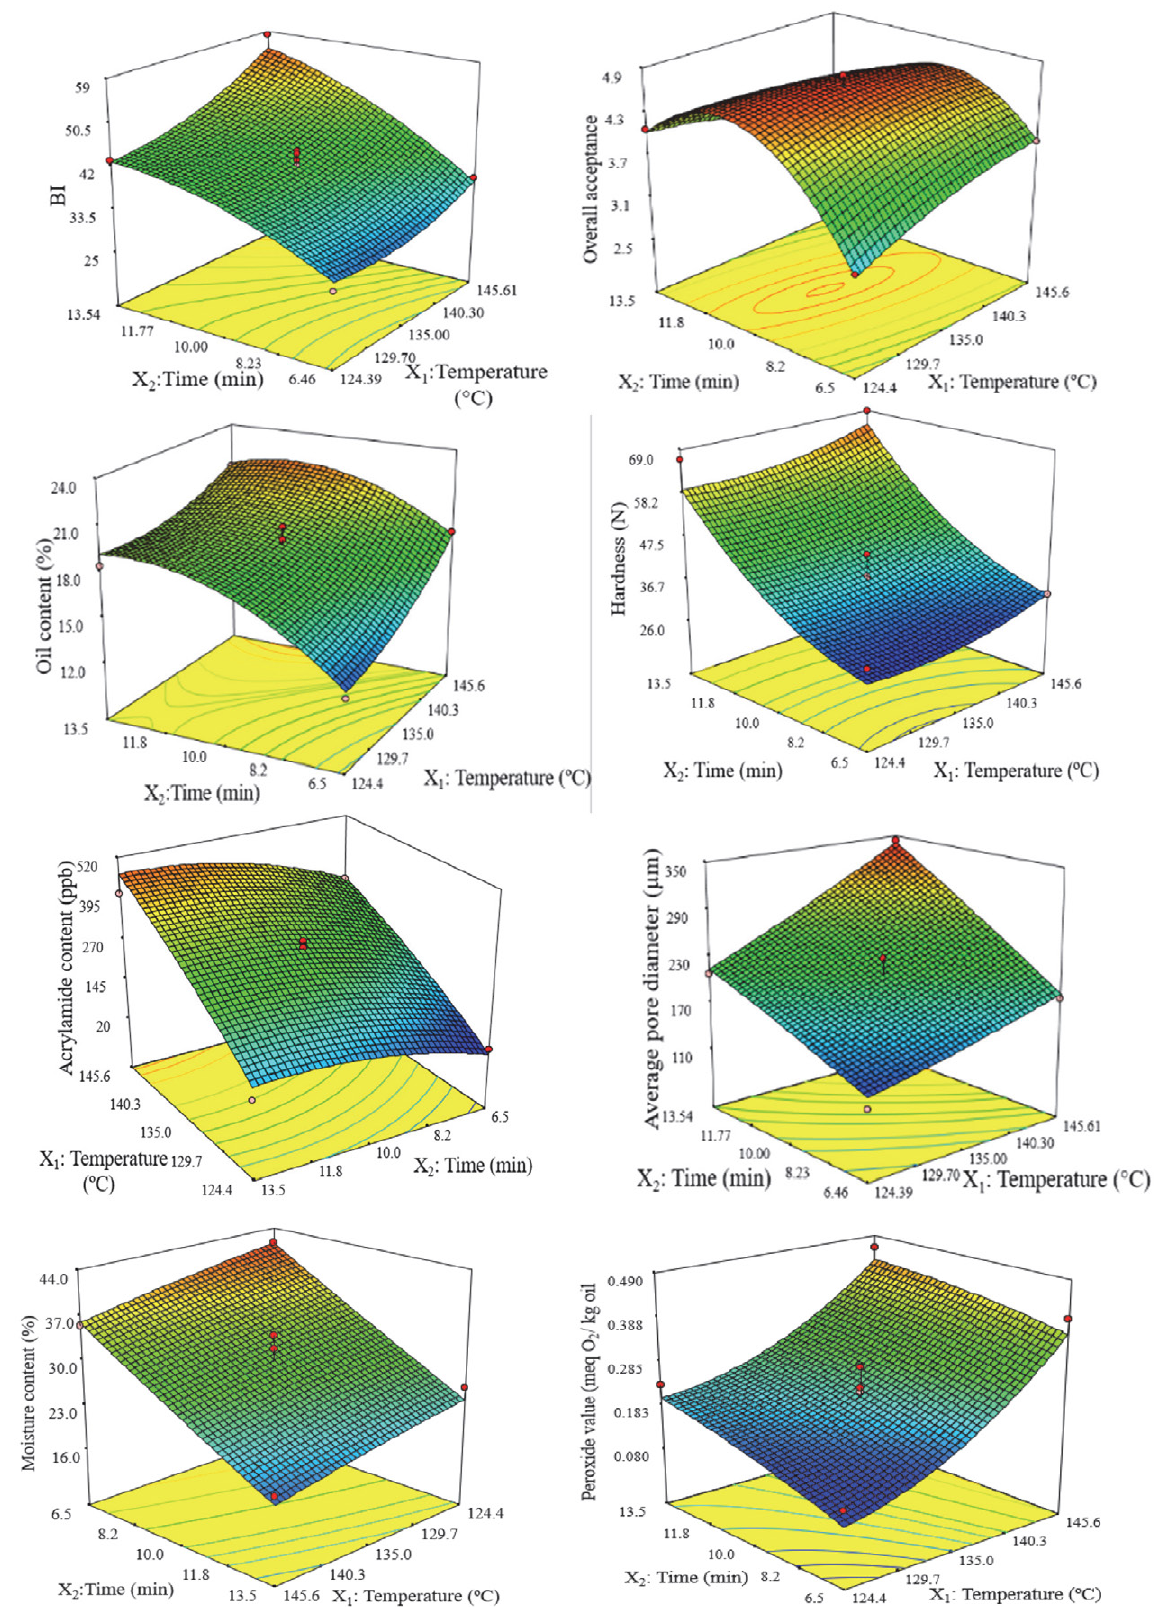
Fig. 2 Response surface graphics and isohips curves for the quality characteristic of vacuum fried French